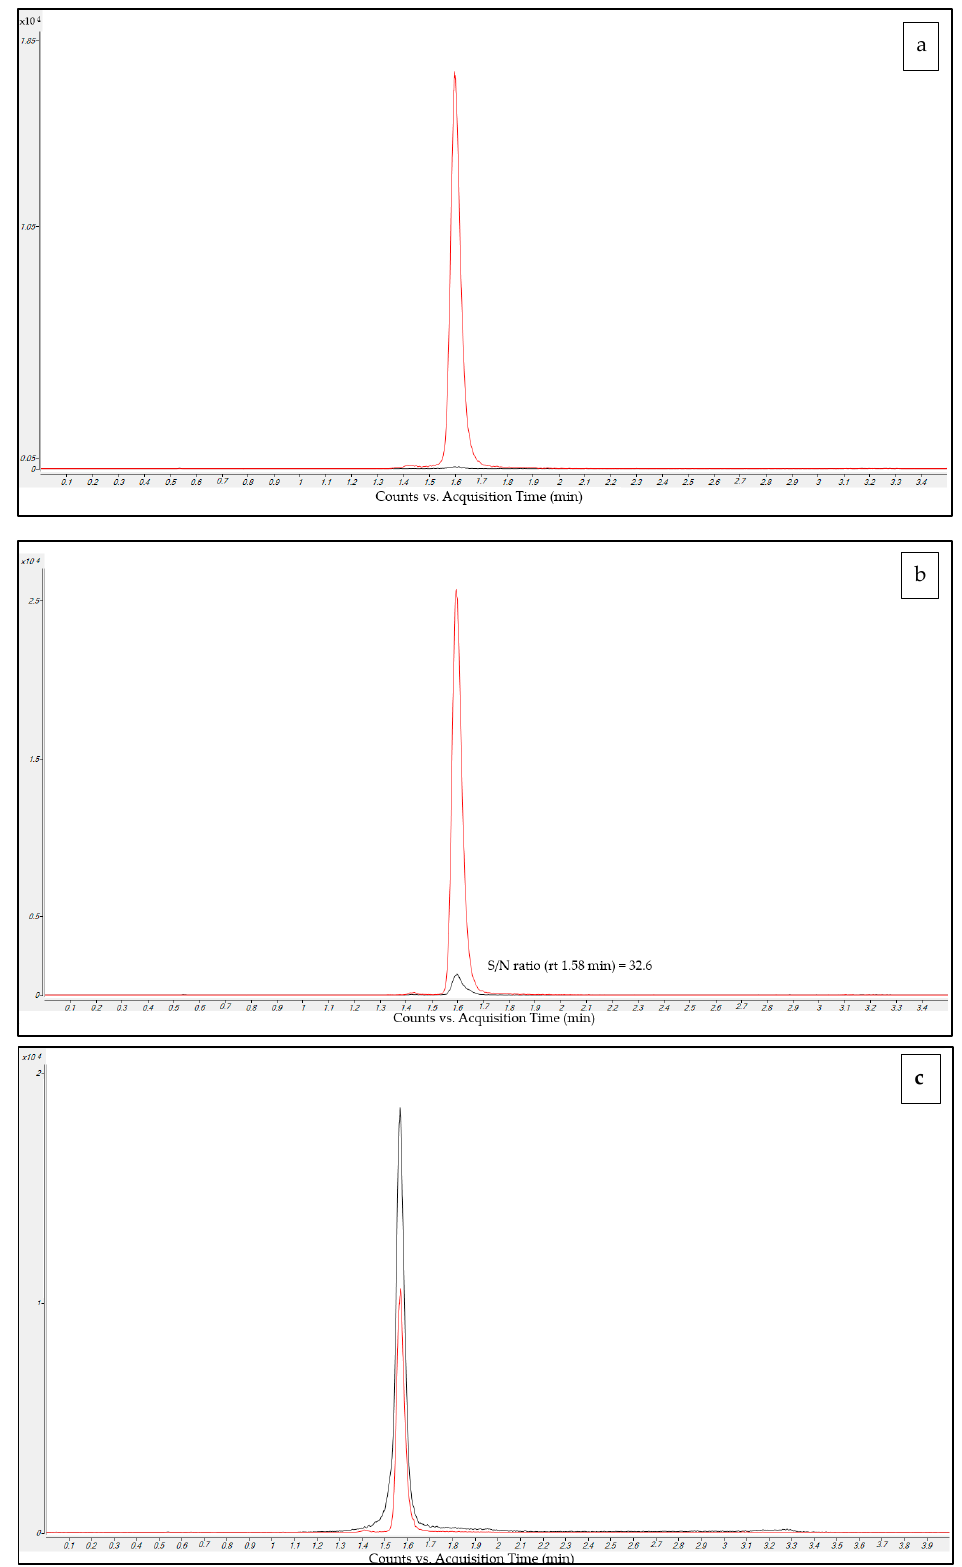
Figure 2. Overlayed MRM chromatograms for C (black) and C-d12 (red) obtained in the analysis of ( a ) a blank sample extracted with the methanol-IS solution, showing the absence of peaks related to C and the presence of a well-defined peak for C-d12; ( b ) a LOQ sample with printed S/N ratio (SNR); ( c ) a real patient sample showing good peak shape and resolution of specific peaks both for C standard and C-d12.